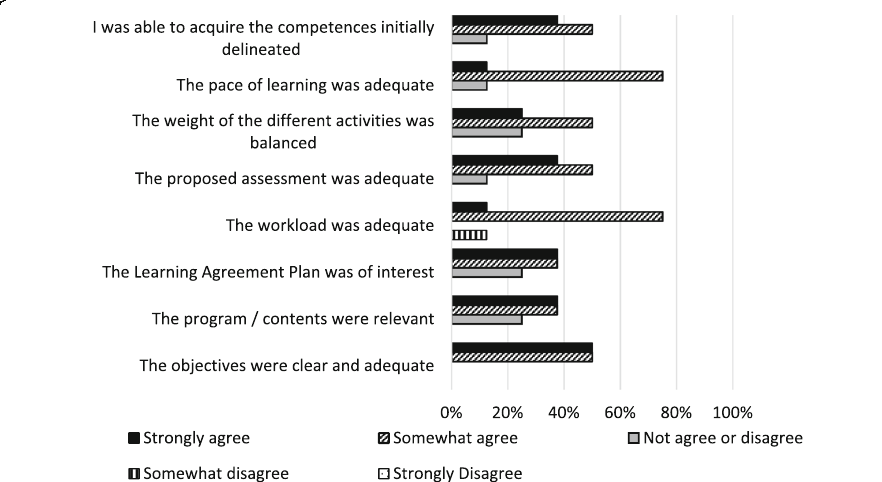
Fig. 1 Students ’ perceptions about organization of the